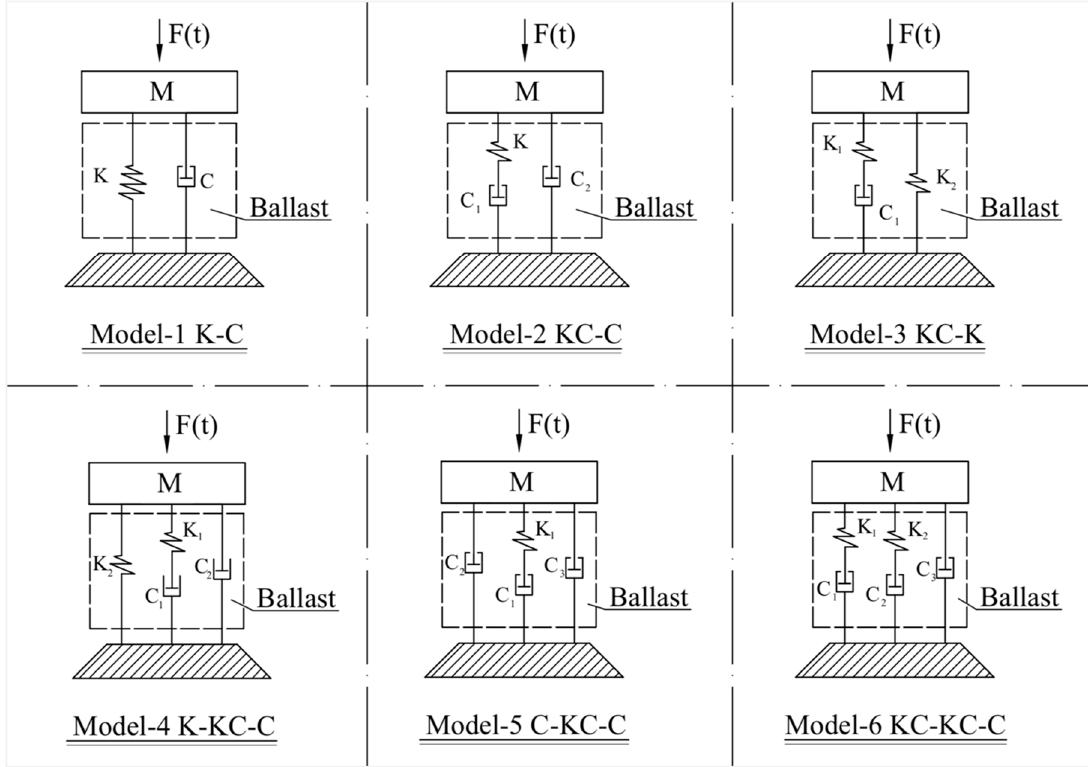
Figure 13. The possible idealisation models.